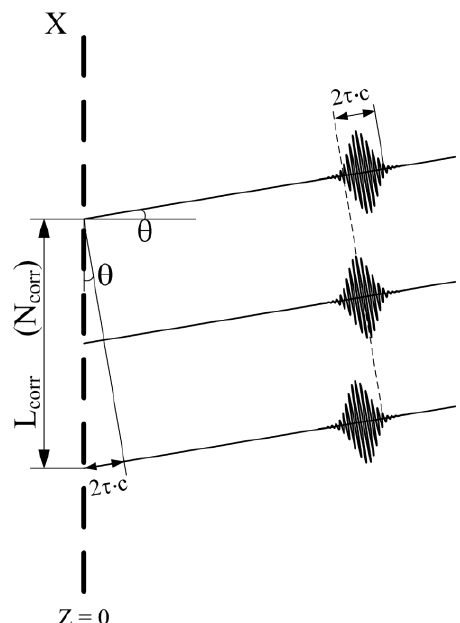
Fig. 6. Explanation for the correlation length relation number